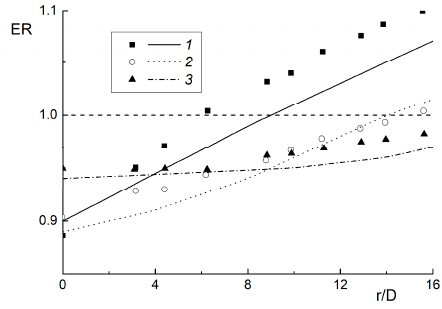
Figure 11. Heat transfer enhancement ratios along the radial distance for various types of signal. Points are the measurements results of [16] and lines are authors’ simulations. Re = 7500, D = 15 mm, H / D = 3, q W = 420 W/m 2 , f = 1.25 Hz. 1 —rectangular; 2 —sinusoidal, 3 —triangular.